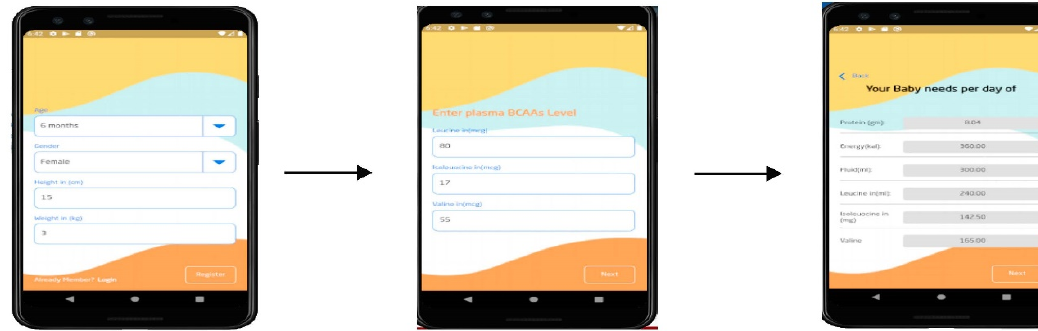
Figure 3. MSUD patient profile.